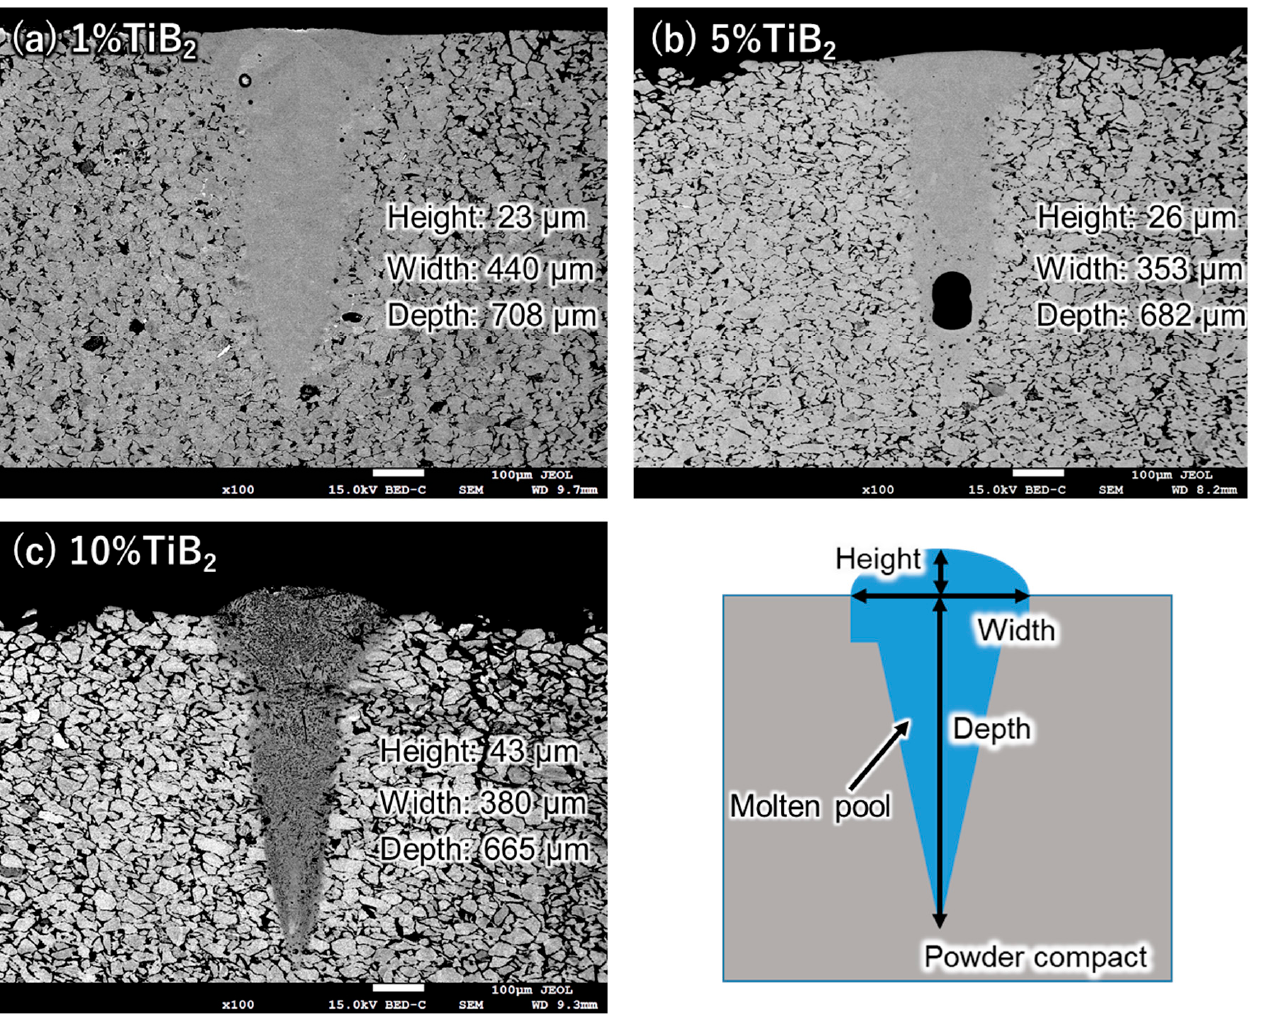
Figure 9. Cross-sectional COMPO images of molten pools induced by a single laser irradiation of Ti64- ( a ) 1, ( b ) 5, and ( c ) 10 mass% TiB 2 pre-mixed powder compacts.